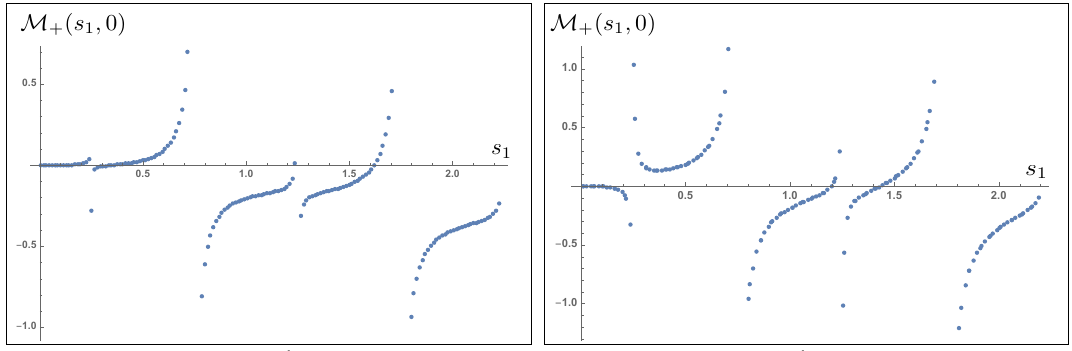
Figure 3 . The plot of Mellin amplitude M + ( s 1 , s 2 = 0) for m max = ‘ max = 2 (left) and m max = 4 , ‘ max = 14 (right). The double zero structure at s 1 = 1 more